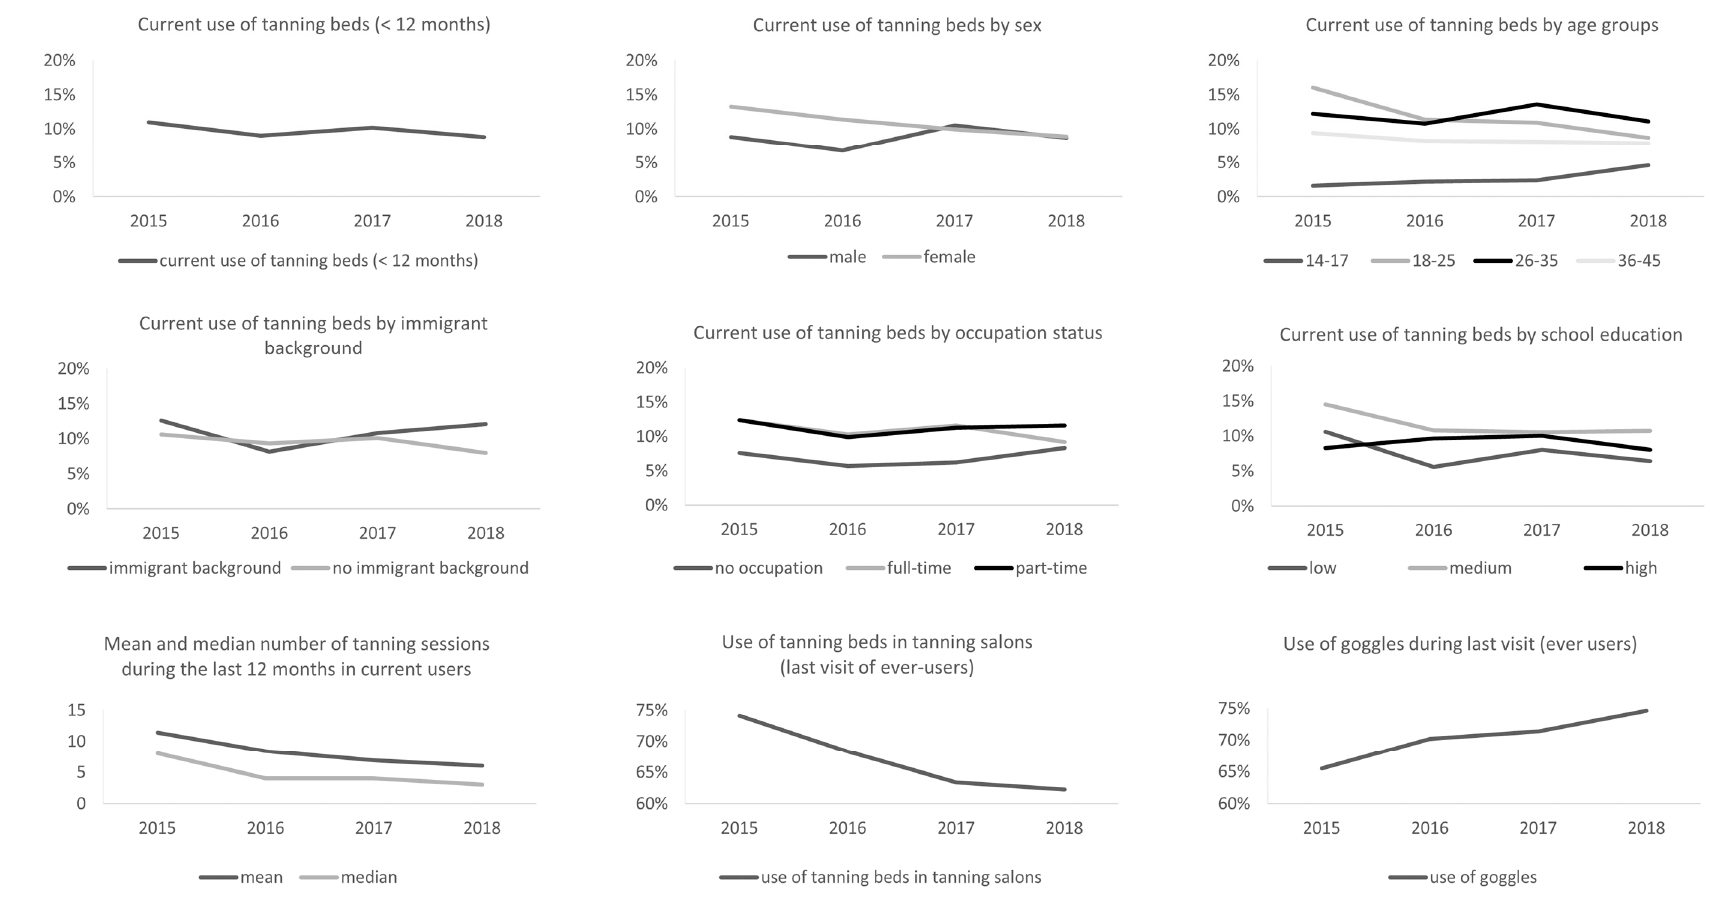
Figure 1. Development of tanning bed use from 2015 to 2018 in Germany. Data are based on the waves 2015, 2016, 2017, and 2018 of the National Cancer Aid Monitoring (NCAM). Data are weighted by sex, age, and education to be representative for Germany. n = 3000 individuals aged 14 to 45 years (per wave).